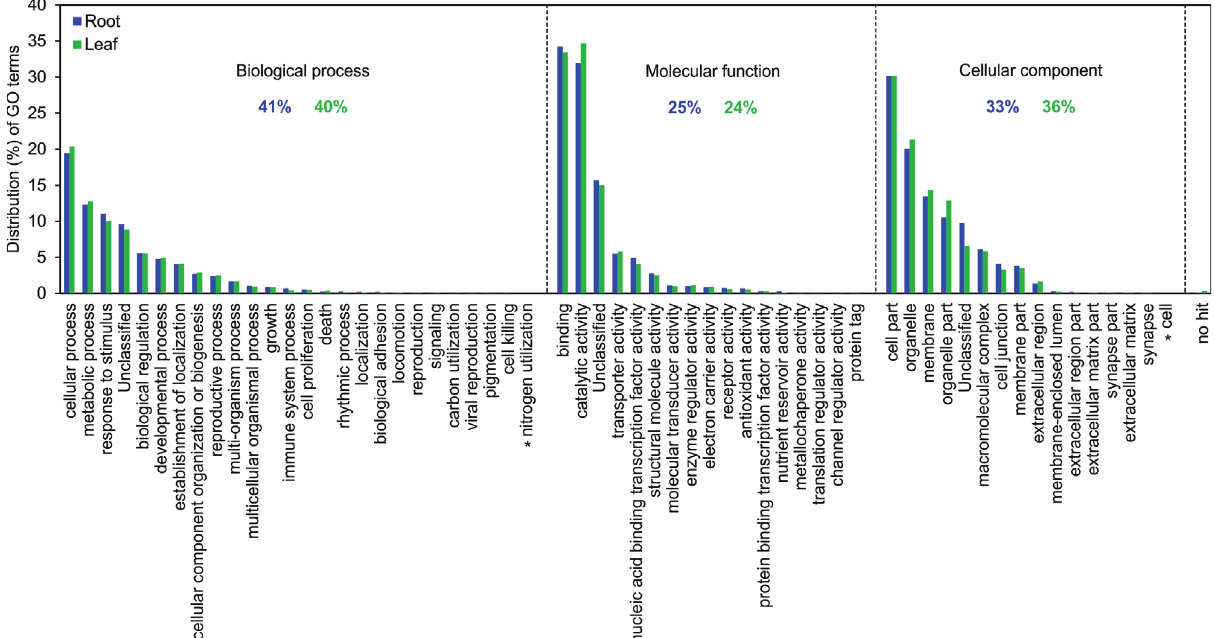
Figure 1 - Functional annotation of the 4,422 candidate genes detected in root and leaf tissues of the wheat cultivar MGS1 Aliança under drought stress. Gene Ontology (GO) analysis was performed for three main categories (biological process, molecular function and cellular component). Asterisk indi- cates GO terms present in root tissue only. No-hit sequences correspond to 0.1% and 0.3% of the leaf and root sequences, respectively. Note that a se- quence may have multiples terms associated to